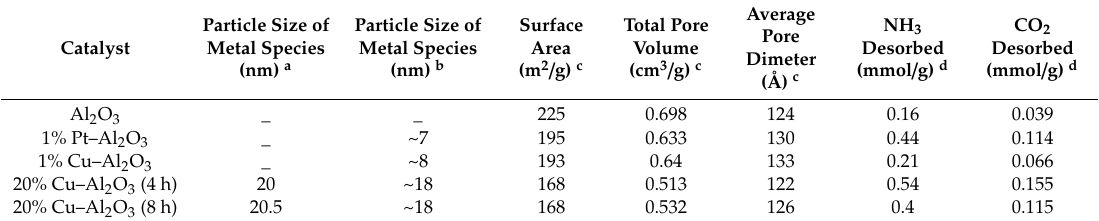
Table 1. Physical properties as well as acidity and basicity values for the different supported catalysts. Catalyst